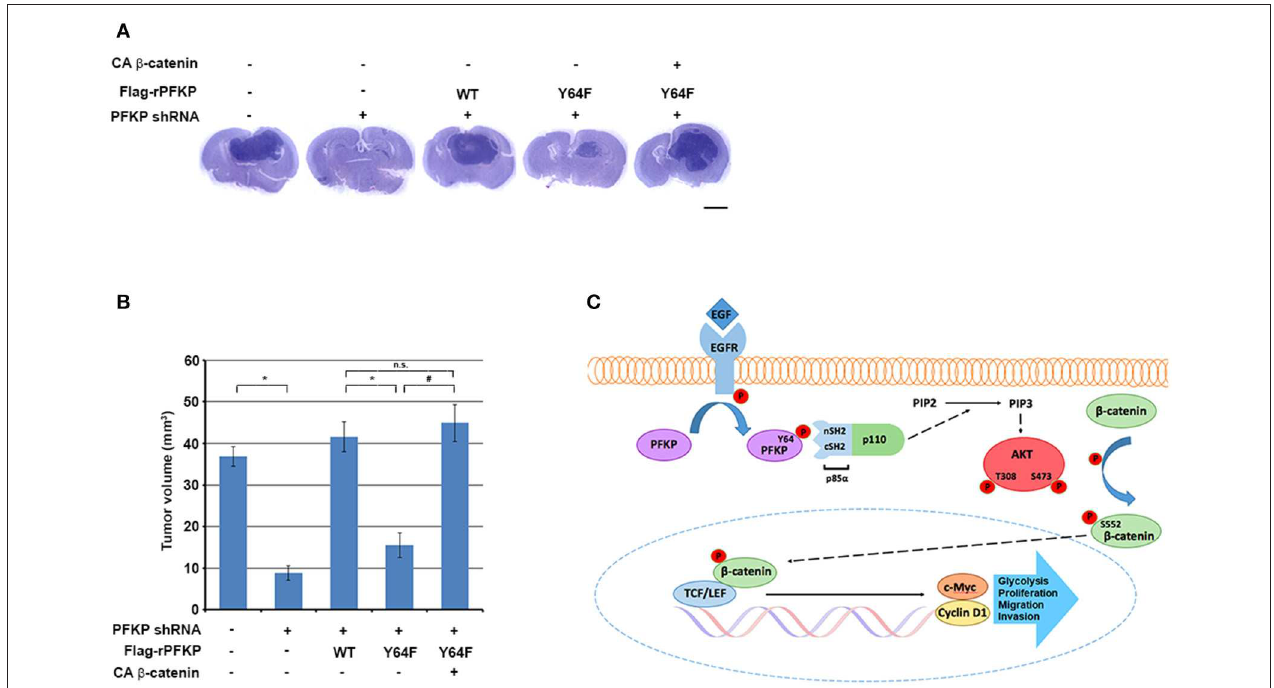
FIGURE 4 | PFKP Y64 phosphorylation-induced β -catenin transactivation promotes brain tumor growth. (A,B) A total of 5 × 10 5 PFKP-depleted U87/EGFRvIII cells with reconstituted expression of the indicated proteins was intracranially injected into athymic nude mice. After 2 weeks, the mice were euthanized and examined for tumor growth. Hematoxylin-and-eosin–stained coronal brain sections show representative tumor xenografts (A) . Tumor volumes were measured (B) . Data represent the means ± SD of seven mice (bottom panel). * P < 0.001, # P < 0.001, based on the one-way ANOVA; n.s., not significant. Scale bar, 2mm.